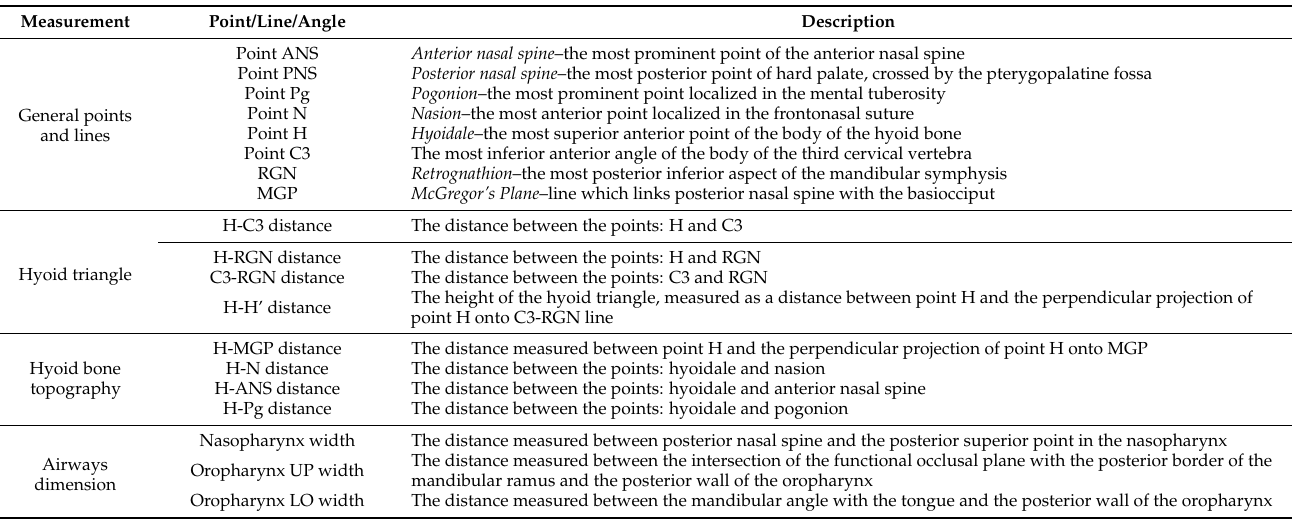
Table 1. Reference points, lines, and angles used in cephalometric analysis to assess the position of the hyoid bone and the width of nasopharynx and oropharynx after occlusal splint therapy combined with physiotherapy in patients diagnosed with temporomandibular joint disorders